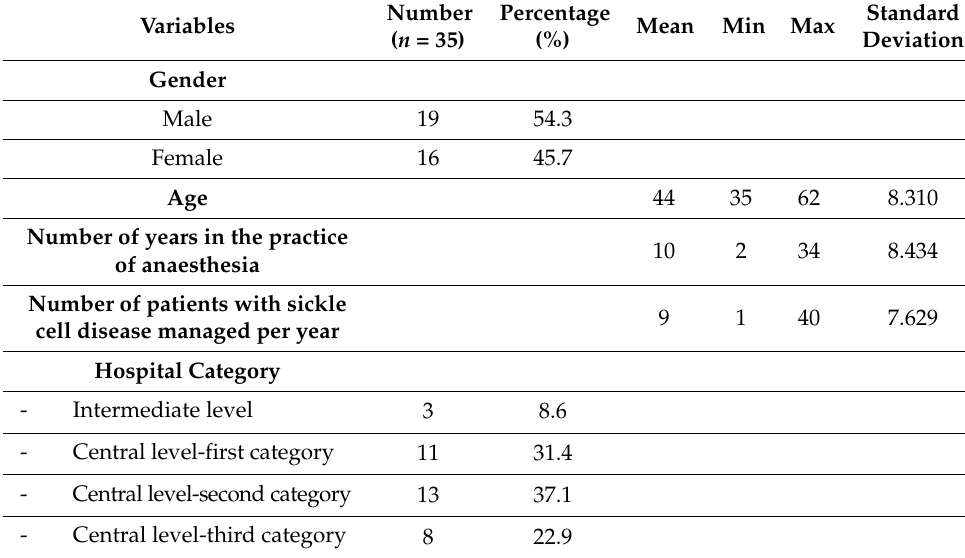
Table 1. Socio-demographic characteristics of